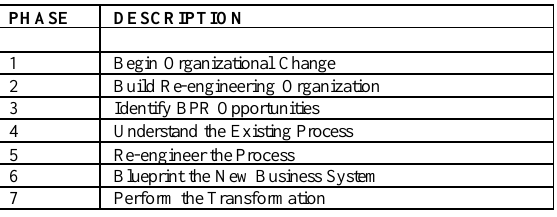
Table 1: Project Phases Required For Successful